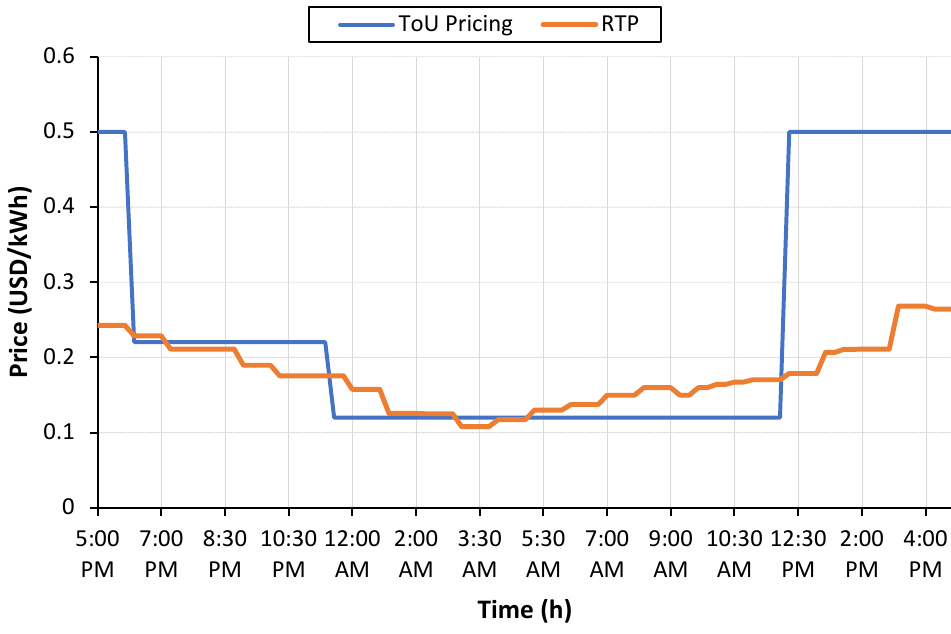
Figure 7. ToU and RTP signals .